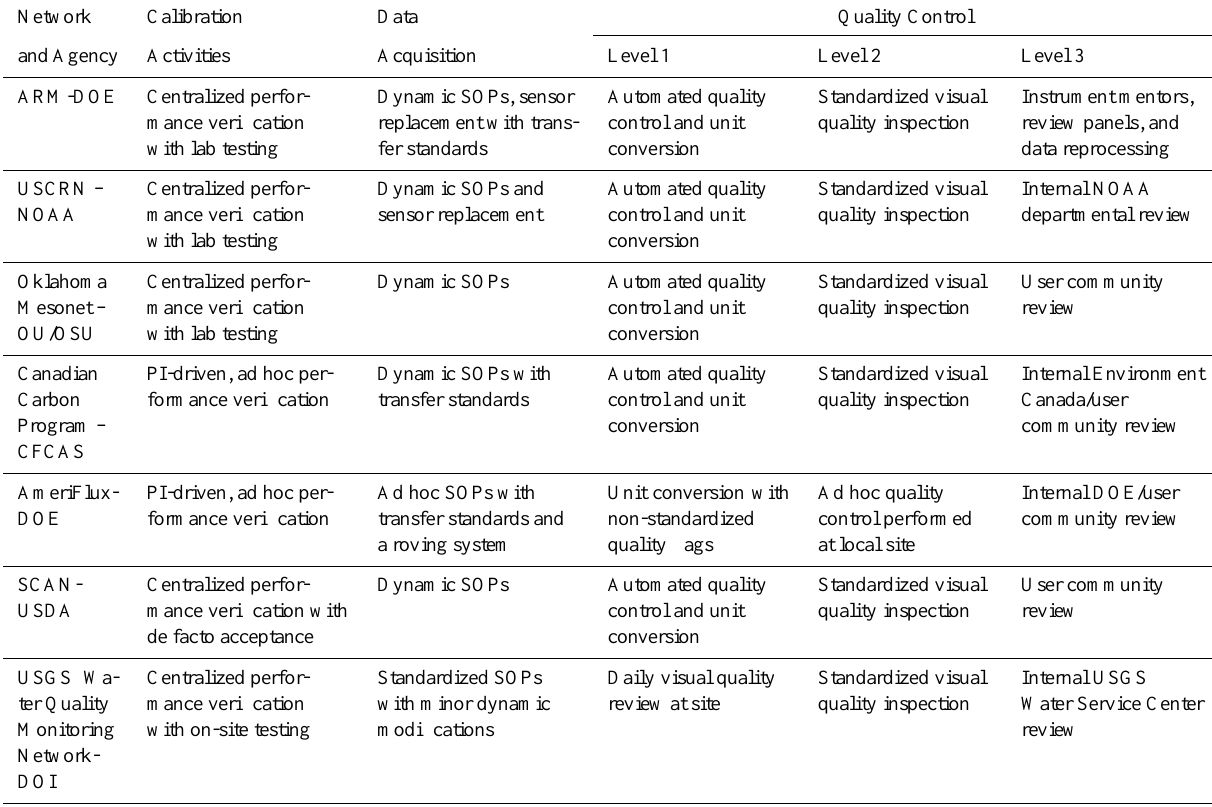
Table 1. Example quality assurance plans currently in use at large environmental